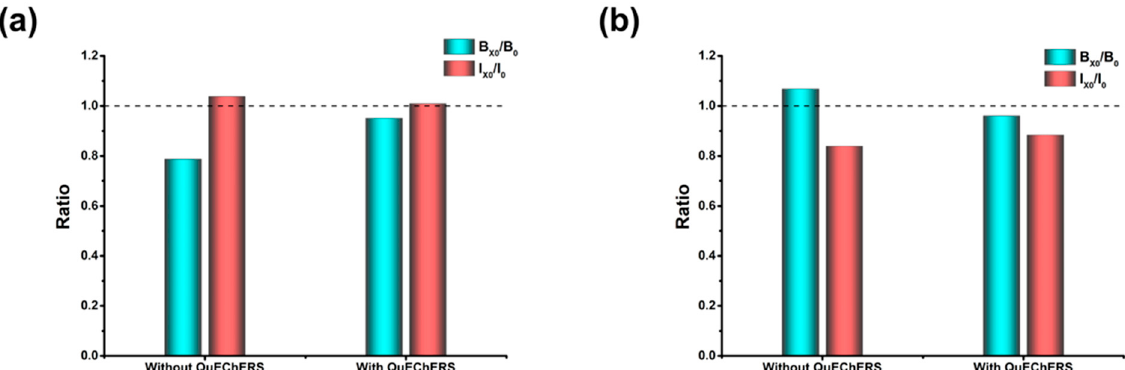
Figure 1. The comparison of extraction with or without QuEChERS procedure. ( a ) MRL 60 µ g/kg; ( b ) MRL 500 µ g/kg. The I 0 and I X0 were the inhibition values of solvent and matrix at 0.5 ng/mL, respectively; the B 0 and B X0 were the values of blank solvent and blank matrix, respectively. The ratio was the value of B X0 / B 0 or I X0 /I 0 .